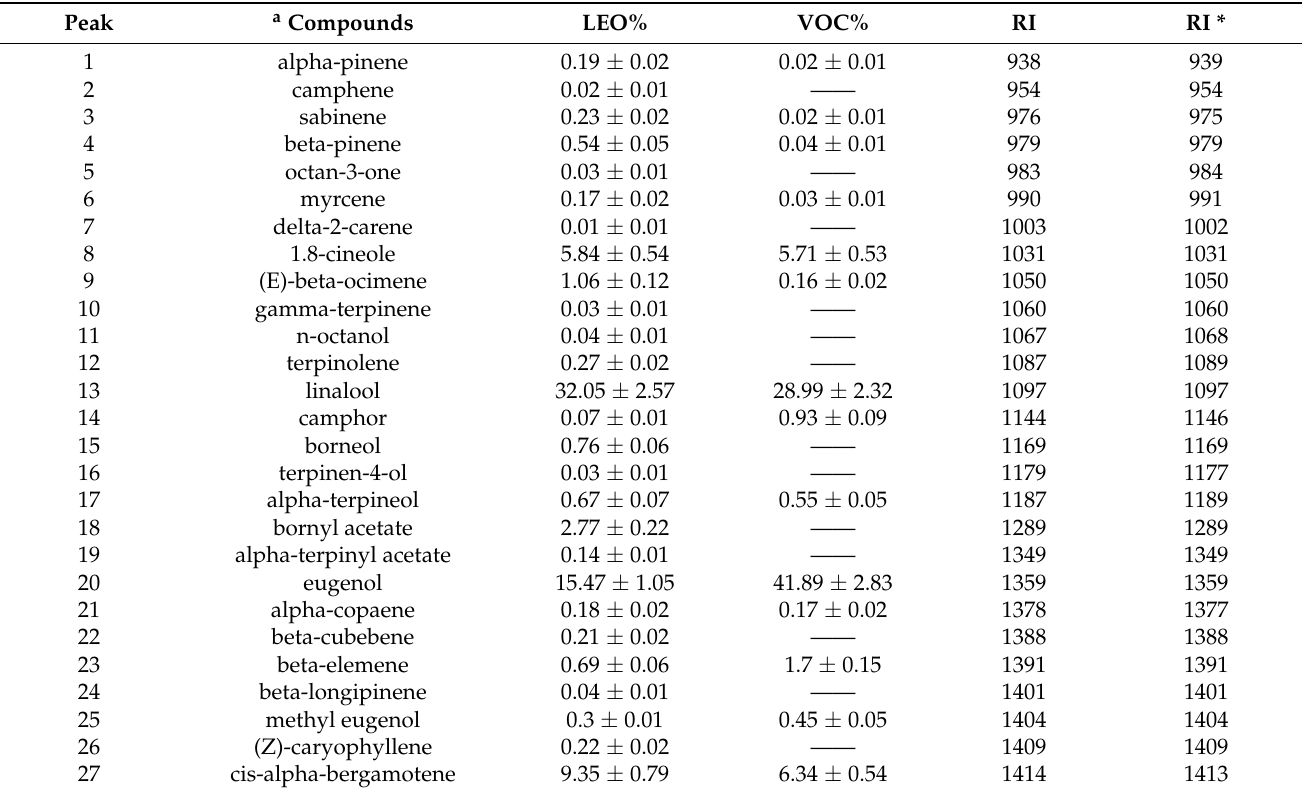
Table 1. Chemical composition (as percentages) of O. basilicum leaf essential oil (LEO%) and peltate trichomes (VOC %).